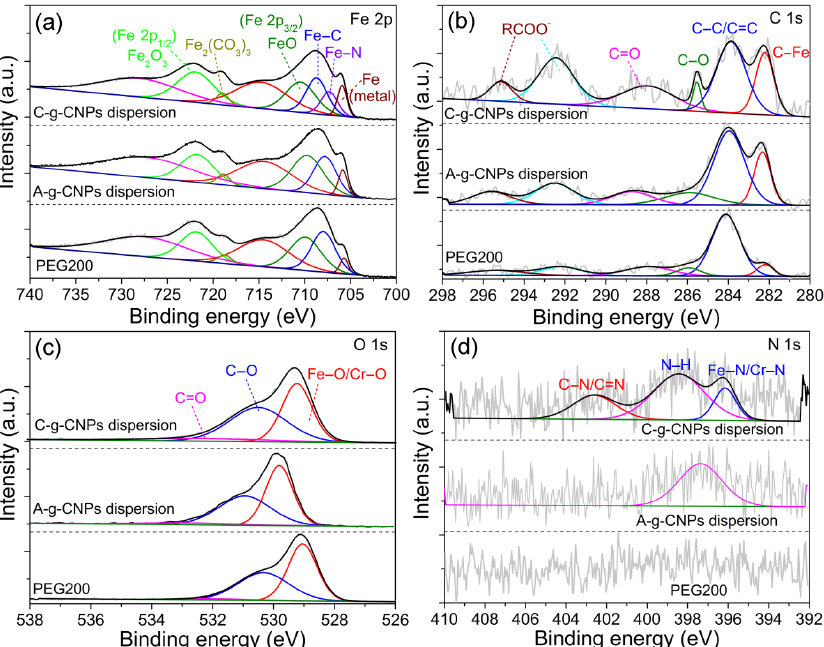
Fig. 16 Fine XPS (a) Fe 2p, (b) C 1s, (c) O 1s, and (d) N 1s spectra of the wear track surfaces of disks lubricated by PEG200, and